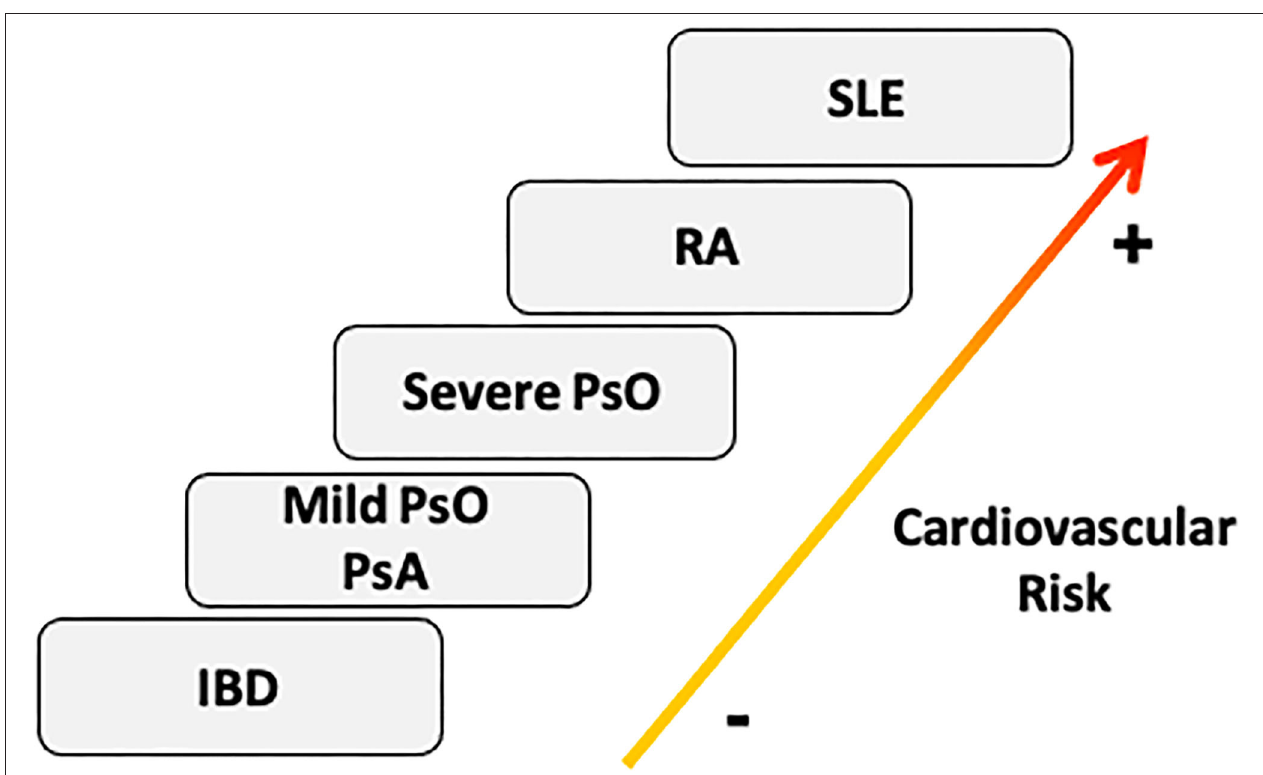
FIGURE 2 | Cardiovascular risk stratification in Immunomediated diseases. According to the prevalence of cardiovascular risk factors and the incidence of cardiovascular events, we should consider SLE as the IMID with highest cardiovascular risk burden, followed by RA, PsO, PsA, and IBD (20). The severity of skin involvement could be essential to classify the cardiovascular profile of psoriatic disease ( 21). IBD, inflammatory bowel disease; PsA, psoriatic Arthritis; PsO, Psoriasis; RA, Rheumatoid Arthritis; SLE, systemic lupus